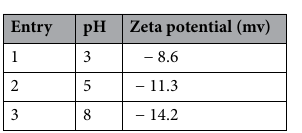
Table 1. Zeta potential at various